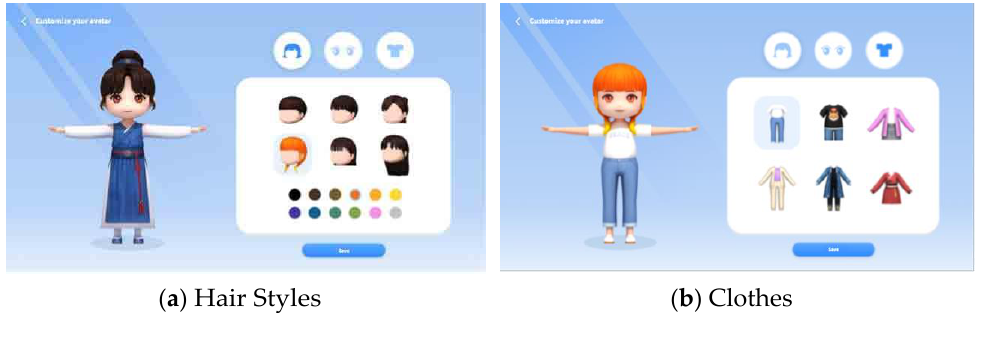
Figure 16. Customizing Avatar.